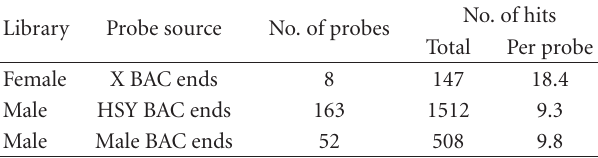
Table 1: Results of papaya male and female BAC library screenings. Library